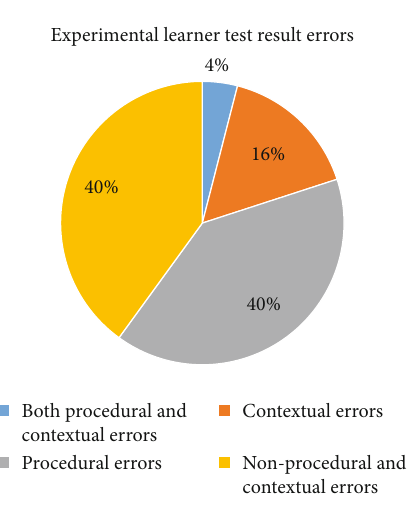
Figure 17: Experimental group test result errors.